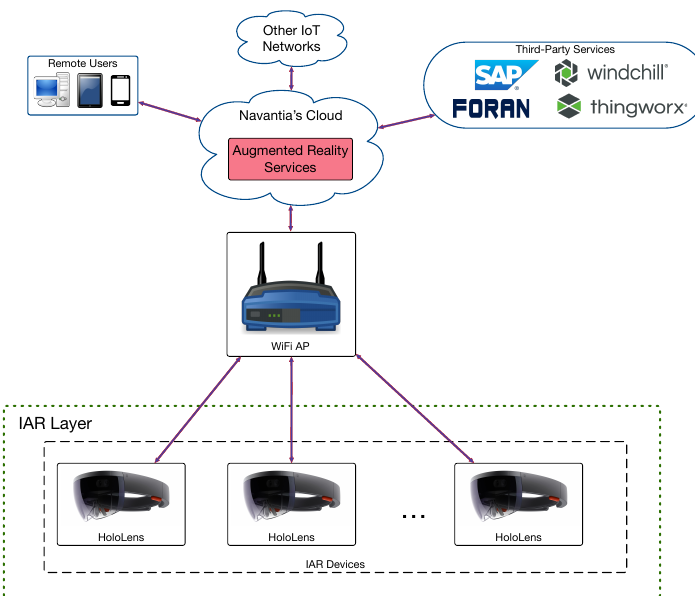
Figure 2. Implemented cloud-based architecture.